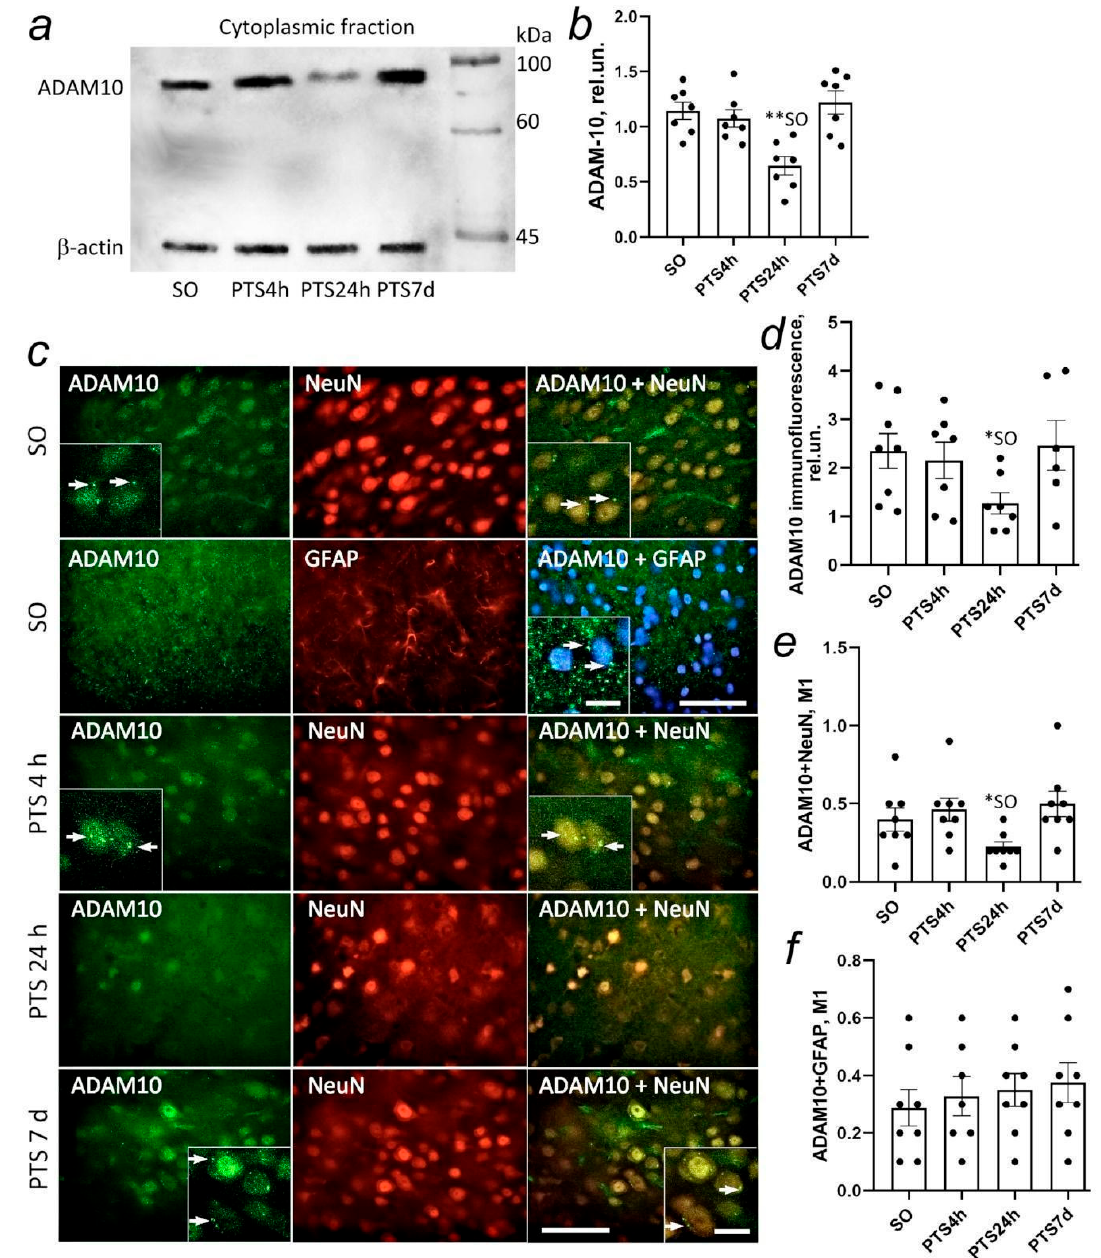
Figure 3. Changes in ADAM10 expression in the penumbra at 4 h, 24 h, and 7 days after PTS in the rat cerebral cortex (PTS 4 h, PTS 24 h, and PTS 7d, respectively) relative to the cortex of sham-operated rats (SO). ( a ) ADAM10 in the cytoplasmic fraction of the cortex of sham-operated animals (SO) and at 4 (PTS 4 h), 24 (PTS 24 h), and 7 days (PTS 7d) after PTS; ( b ) ADAM10 level in relative units at different times after PTS. The indices of the groups of sham-operated animals at 4 h, 24 h, and 7 days after irradiation had no statistically significant differences, therefore the indices of the three groups were combined. ( c ) Immunofluorescence and image overlay of ADAM10 (green), NeuN (red), and GFAP (red). Image overlay of ADAM10 with NeuN and with Hoechst. Scale bar 100 µ m. Insert: enlarged image. Scale bar 50 µ m. Arrows show granularity (clusters) in the area of the cytoplasmic membrane. ( d ) ADAM10 fluorescence in penumbra cells after PTS and in the cortex of sham-operated rats. ( e ) Localization of ADAM10 in penumbra neurons. ( f ) Localization of ADAM10 in penumbra astrocytes. One-way ANOVA. M ± SEM. n = 6–8. * p < 0.05 compared to the SO. ** p < 0.01 compared to the